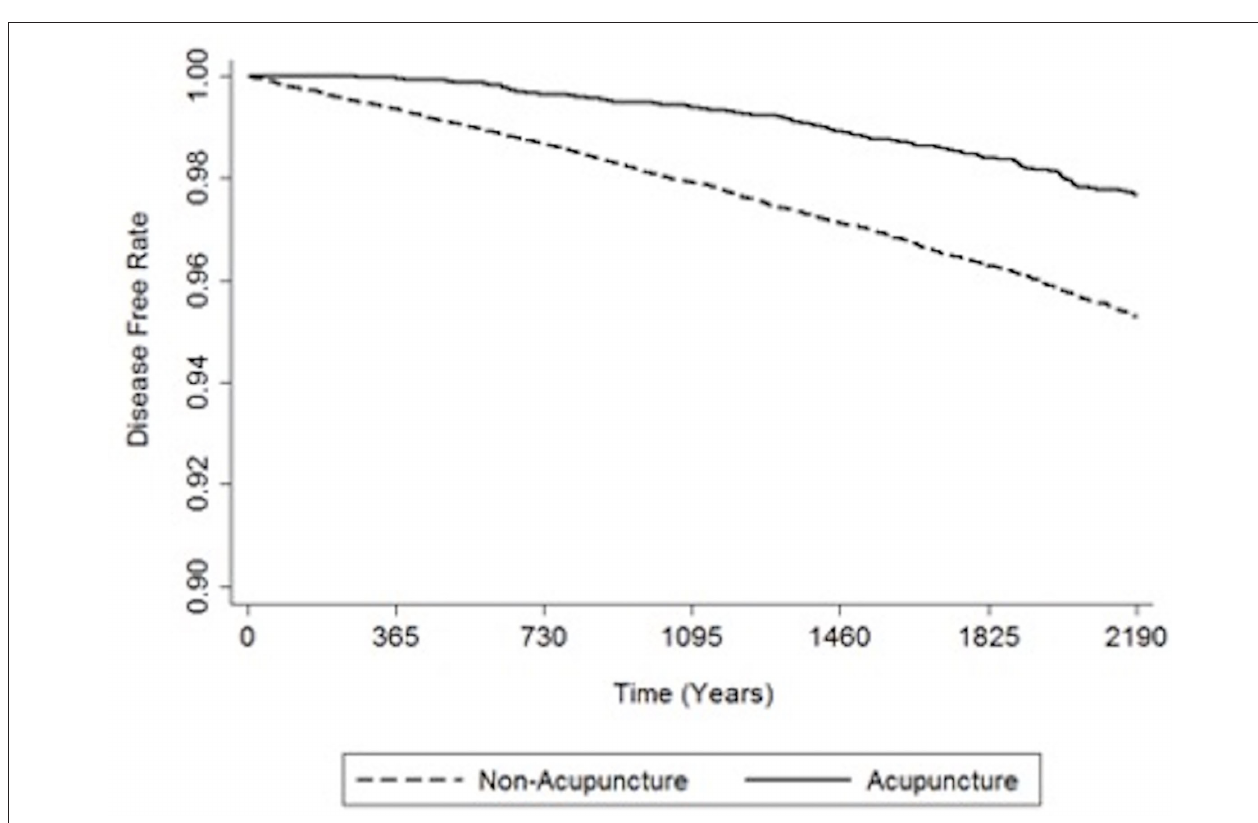
FIGURE 4 | Kaplan-Meier curve of the estimated dementia-free proportions of non-stroke patients who received and did not receive acupuncture treatment.